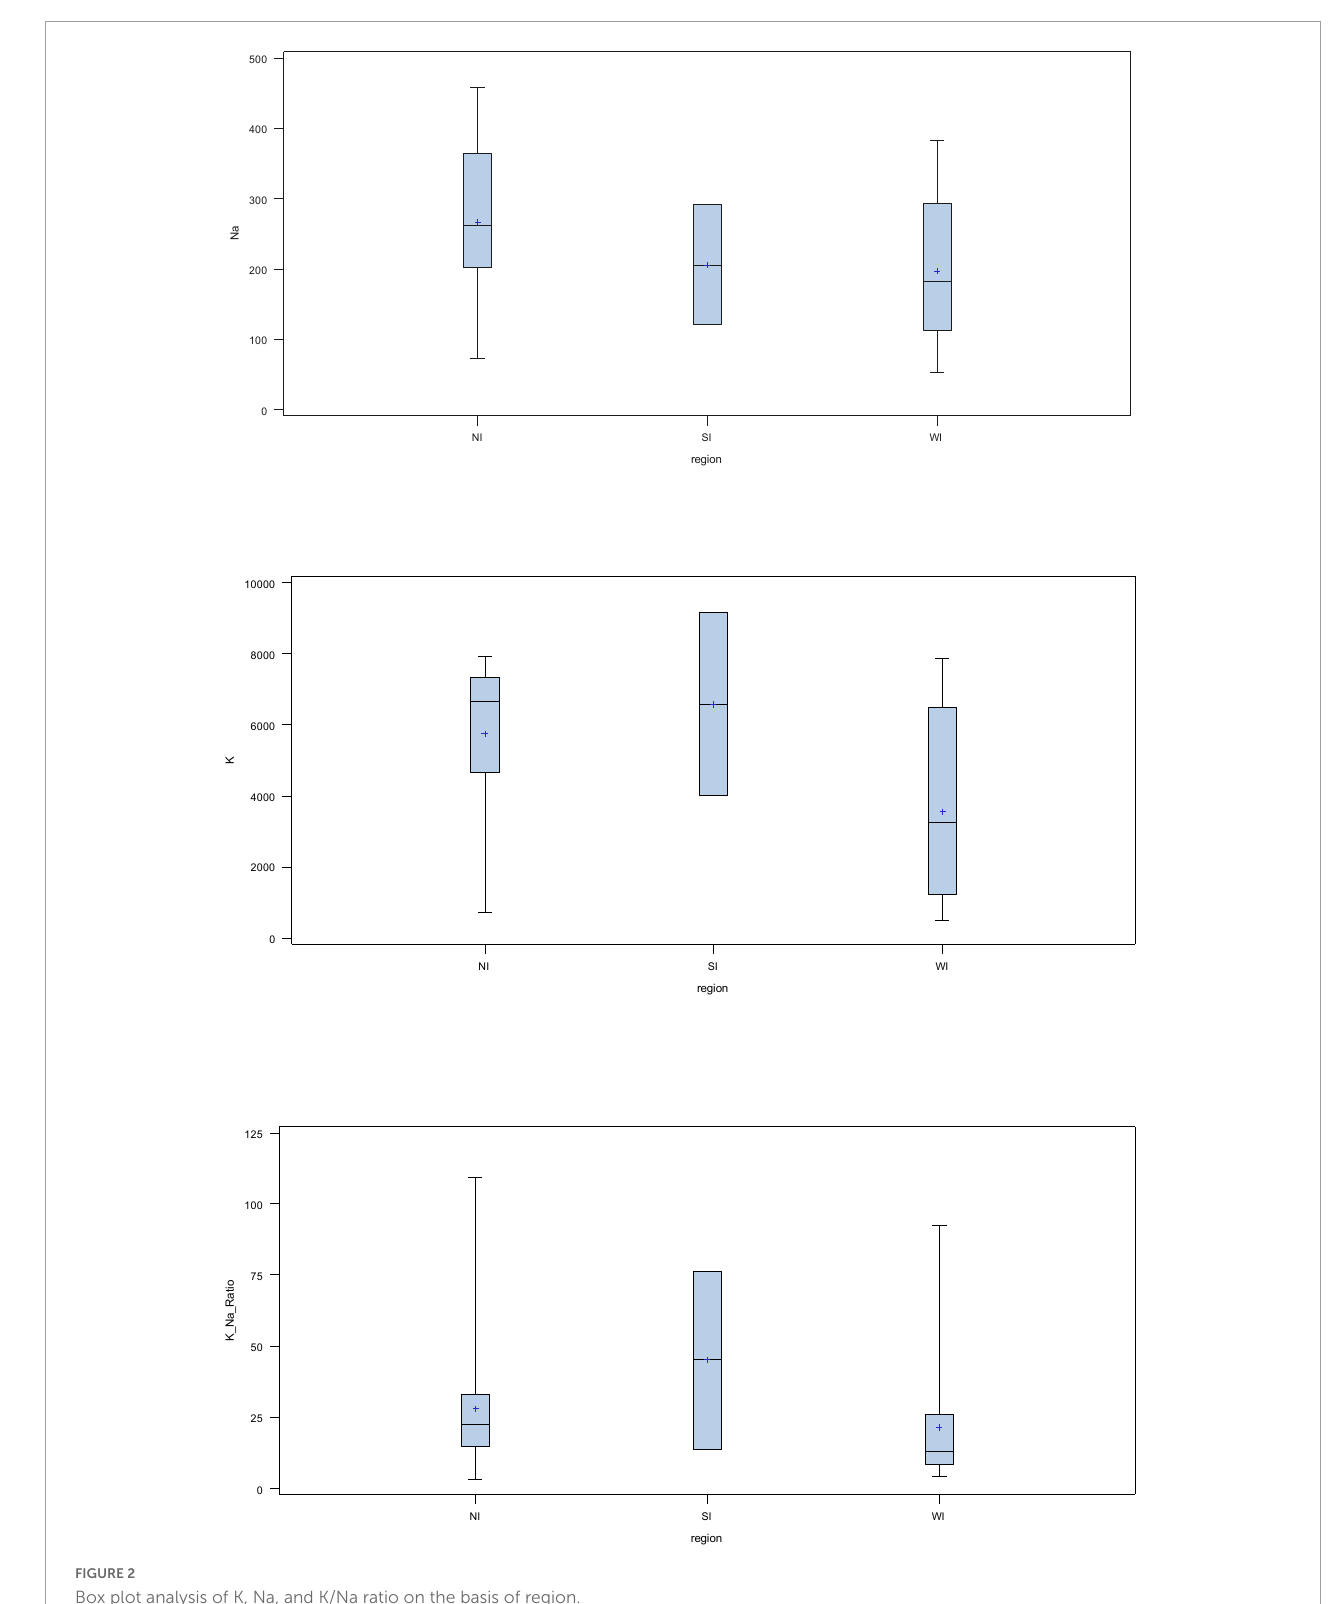
FIGURE2 Box plot analysis of K, Na, and K/Na ratio on the basis of